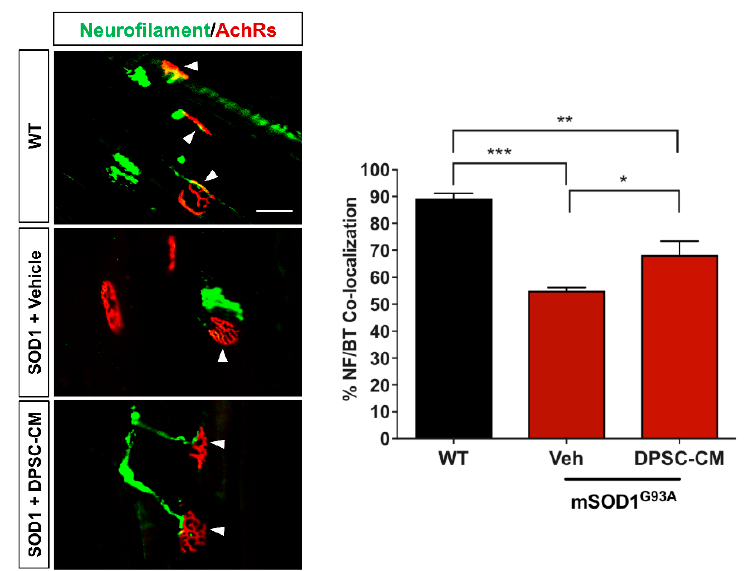
Figure 2. Early DPSC-CM therapy in mSOD1 G93A mice significantly reduced neuromuscular (NMJ) denervation. Administration of DPSC-CM from PD35–47 significantly increased innervated NMJs in the medial gastrocnemius (white arrowheads) compared to vehicle-treated mice. Data represent mean +/ − SEM. Data analyzed via one-way ANOVA. *, p < 0.05; **, p < 0.01; ***, p < 0.001. ( n = 3). Scale bar = 50 μ m.